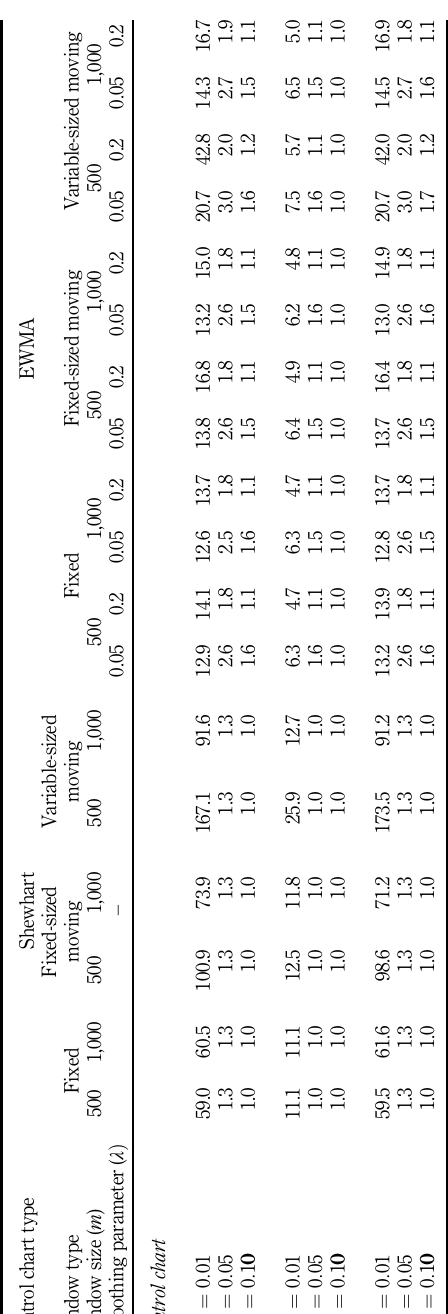
Table 5. Out-of-control AARL values for the Shewhart and EWMA control charts when m 5 500 and 1,000 networks assuming fixed, fixed-sized moving and variable- sized moving windows for simulation case